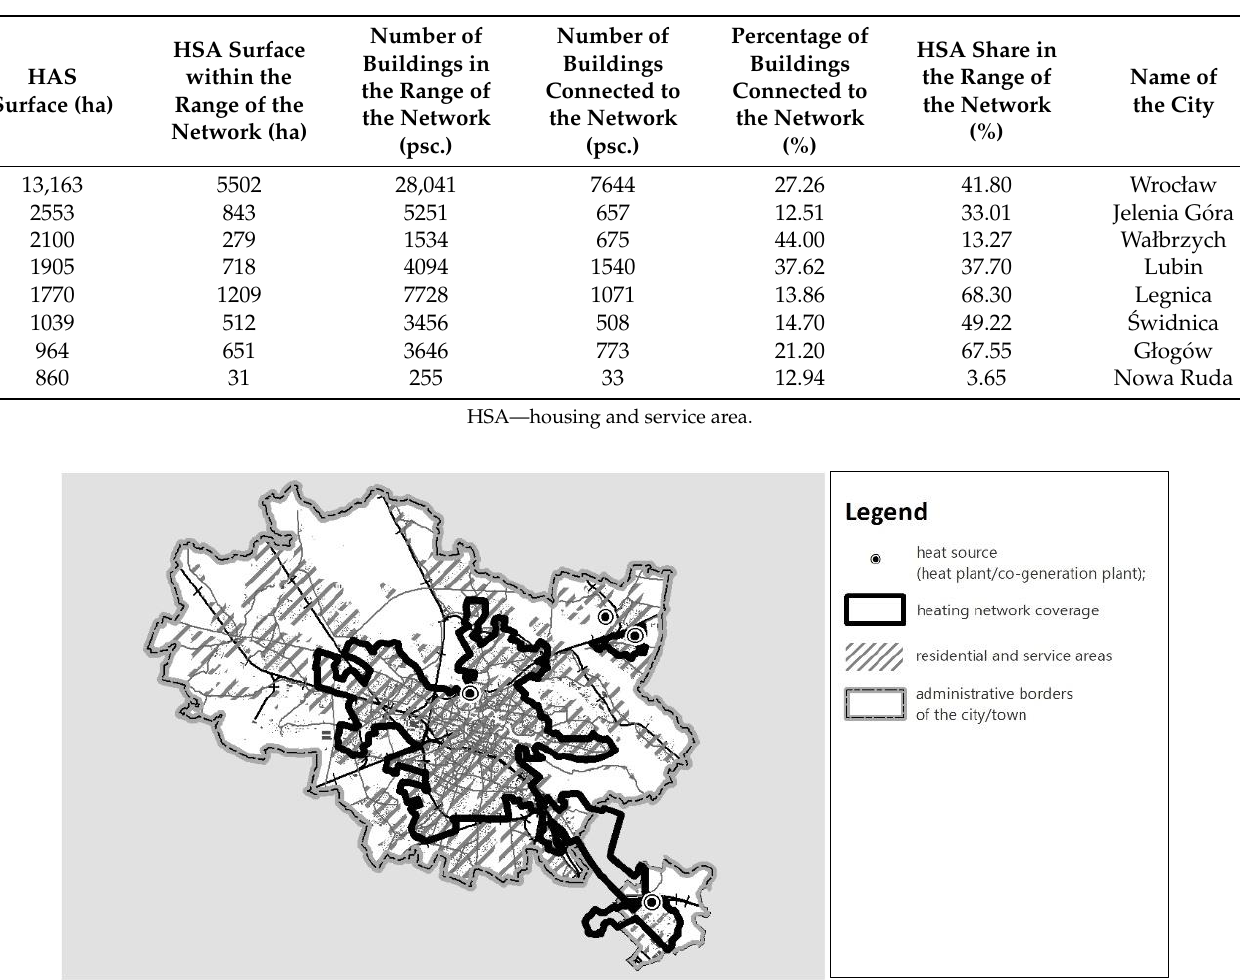
Table 16. Access to the district heating networks in the selected cities of the Dolno´sl ˛askie Voivodeship in view of their land use policy.